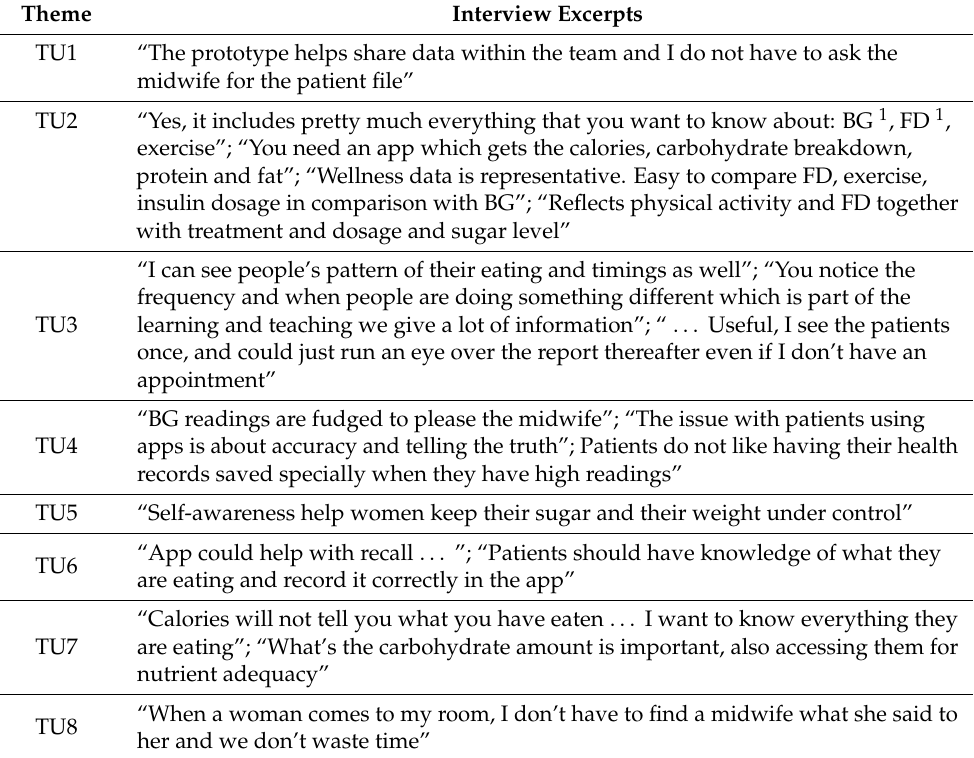
Table 3. Data excerpts supporting system usefulness